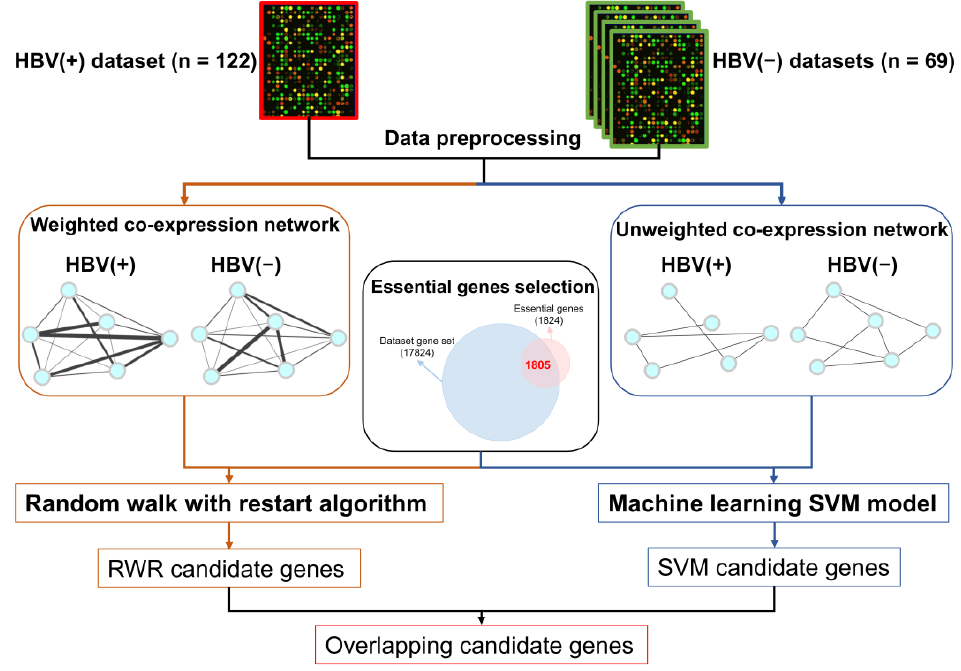
Figure 1. Schematic representation of the workflow of this study.